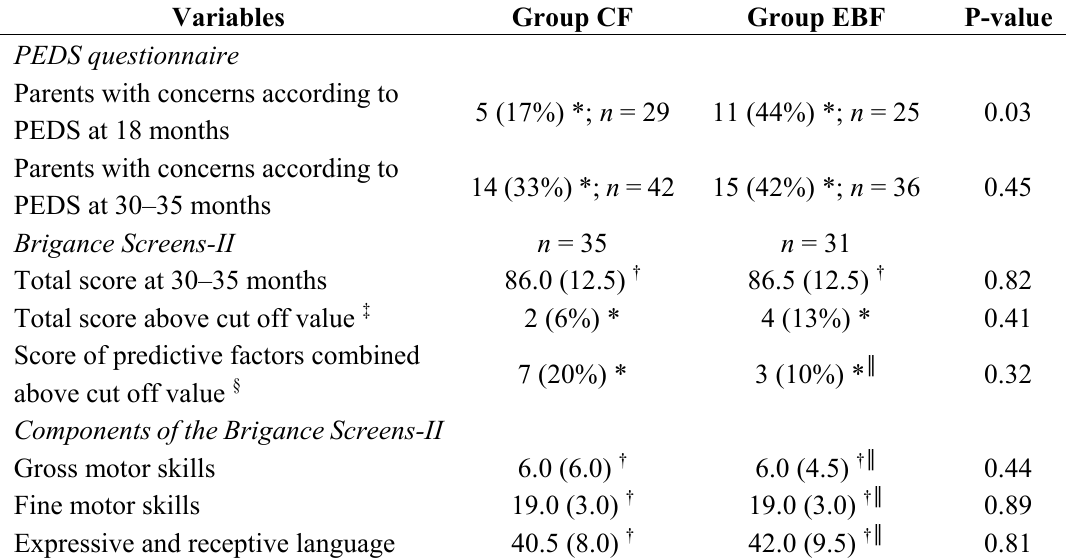
Table 2. Selected measures of developmental and behavioral status for children at 18 months and at 30–35 months of age in the two intervention groups: infants who received complementary foods in addition to breast milk from 4 months (CF) compared with infants who were exclusively breastfed for 6 months